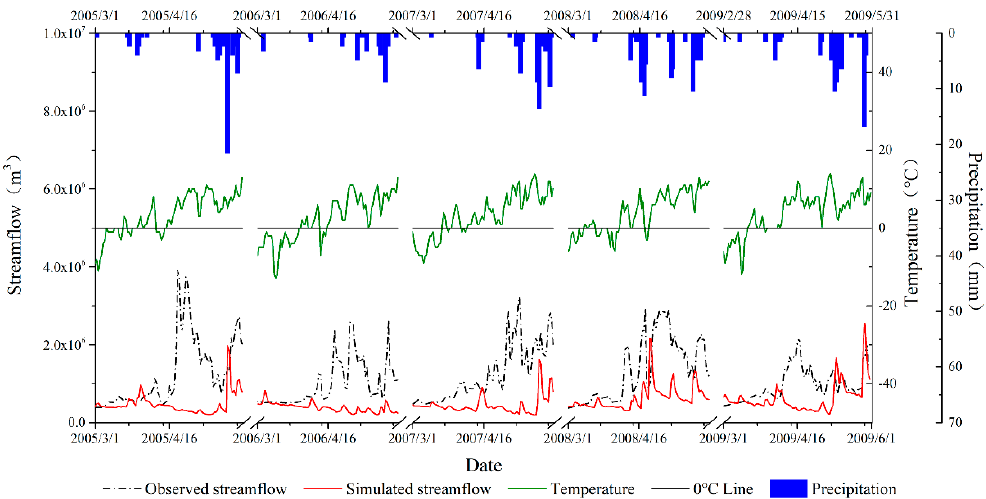
Figure 5. Amplified windows of March to May 2005–2009, in which temperature starts to rise across